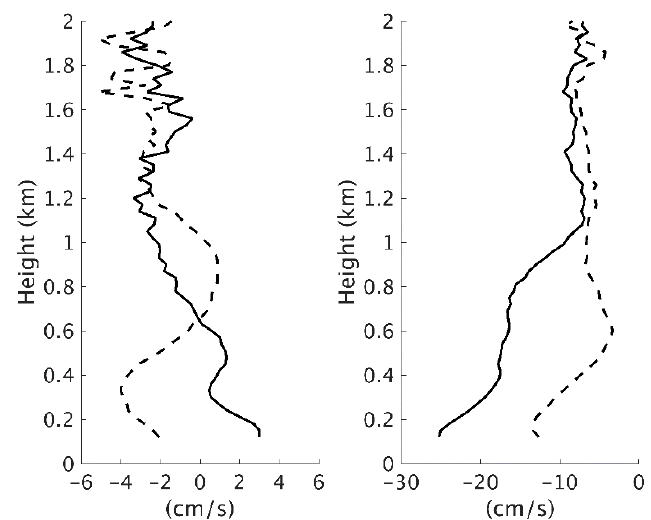
Figure 12. Vertical profiles of annual (solid) and HPE (dashed) vertical wind velocity at CUHK ( left ) and KP ( right ). Positive values refer to upward air motions, whereas negative values represent downward air motions.